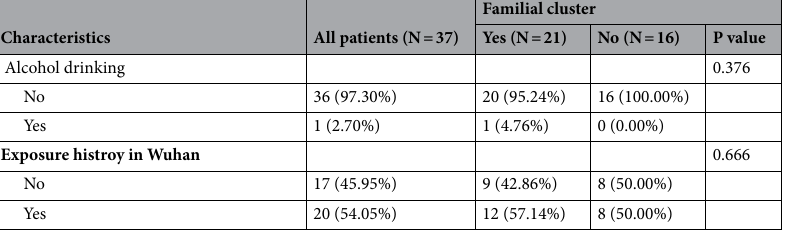
Table 1. The basic characteristics for all the patients and the subgroup divided by family cluster.